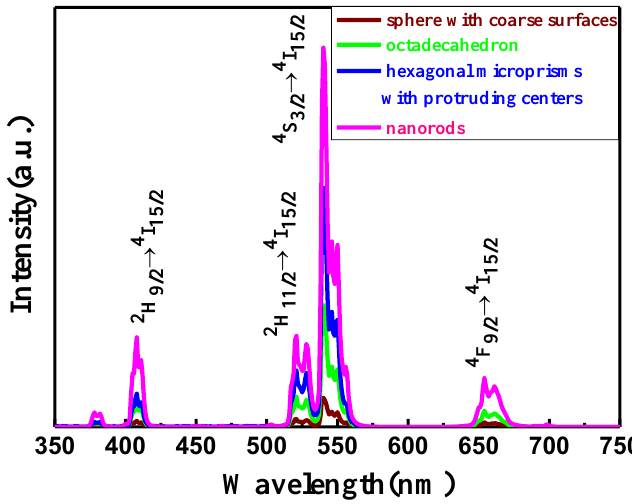
Figure 7. UC Photoluminescence (PL) spectra of NaYF microcrystals with different molar ratios of OA/Ln 3+ under diode laser excitation at 808 nm. Excitation power density, ~390 W/cm 2 .